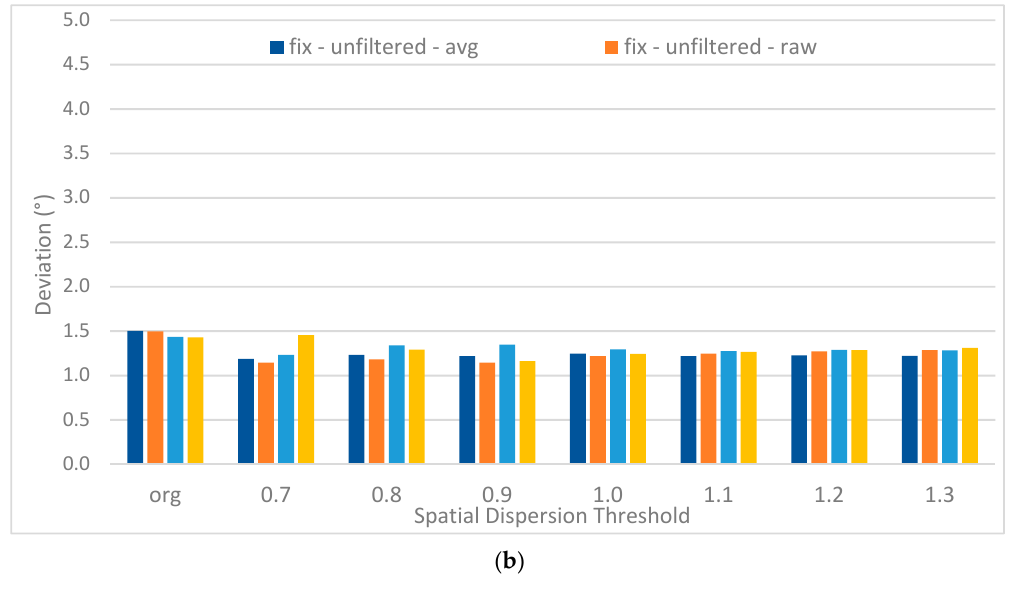
Figure 12. Deviations (visual angle) for the case of threshold 1.0° for 13 targets ( a ) and 5 targets ( b ) for all participants (in °). Table 5. Statistical (repeated measures) tests on the application of the EyeMMV’s algorithm ( df = 7 ⎯ org values + 7 thresholds; df = 6 ⎯ only thresholds).